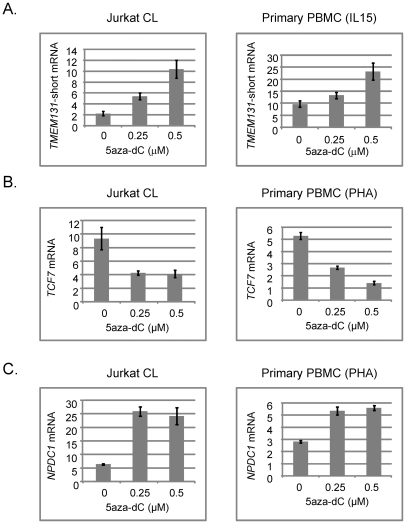
Effects of the demethylating drug 5aza-dC on expression of TMEM131 short isoform, TCF7, and NPDC1 mRNAs in Jurkat cells and normal human T-cells expanded with mitogens.A, Increased expression of TMEM131 short isoform mRNA in Jurkat cells and PBMC exposed to 5aza-dC at the indicated concentrations for 3 days. The short-term cultures of PBMC were grown in the presence of IL-15 to induce proliferation of cytotoxic T-cells and NK cells. B, Decreased expression of TCF7 mRNA in Jurkat cells and PBMC exposed to 5aza-dC at the indicated concentrations for 3 days. The short term cultures of PBMC were grown in the presence of PHA to induce a polyclonal proliferation of T-cells. PHA rather than IL-15 stimulation was utilized for assessing TCF7 expression and response to 5aza-dC because the baseline expression of TCF7 mRNA is high after PHA stimulation but very low after stimulation with IL-15. C, Increased expression of NPDC1 mRNA in Jurkat cells and PBMC exposed to 5aza-dC at the indicated concentrations for 3 days. The short term cultures of PBMC were grown in the presence of PHA to induce a polyclonal proliferation of T-cells. In each experiment a 25 – 40 percent reduction in DNA methylation of the index regions of interest after exposure to the highest dose of 5aza-dC was confirmed by MS-Pyroseq or bisulfite sequencing (data not shown). Cell viability was preserved in each experiment, but net cell proliferation was reduced by approximately 50% at the highest doses of 5aza-dC.